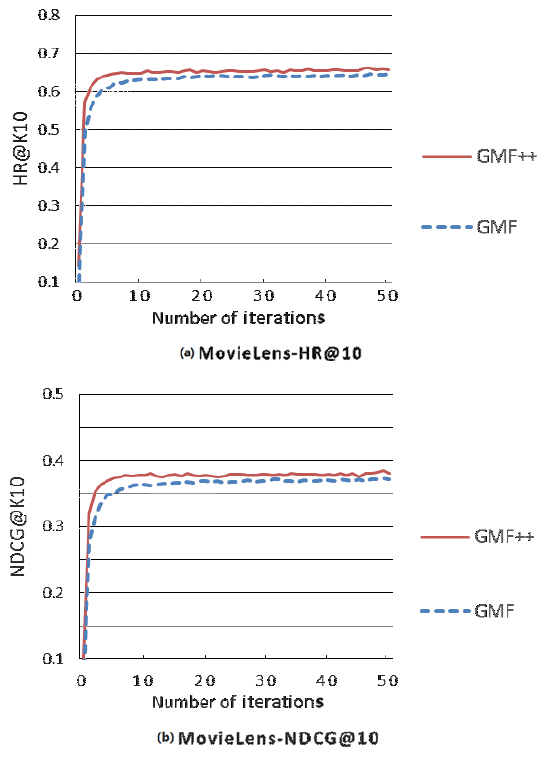
Fig. 5 HR@10 and NDCG@10 w.r.t the number of